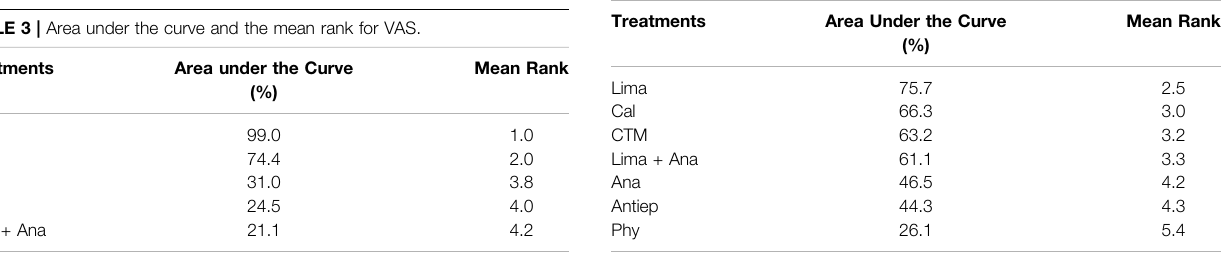
TABLE 4 | Area under the curve and the mean rank for